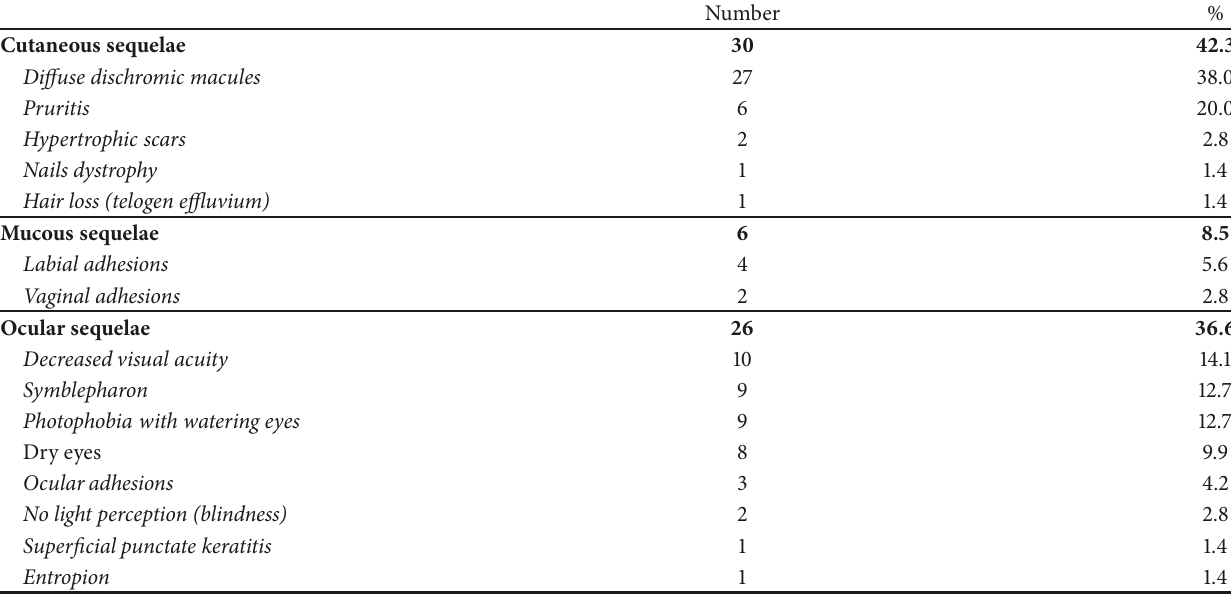
Table 2: Ocular and mucocutaneous sequels in 71 SJS/TEN